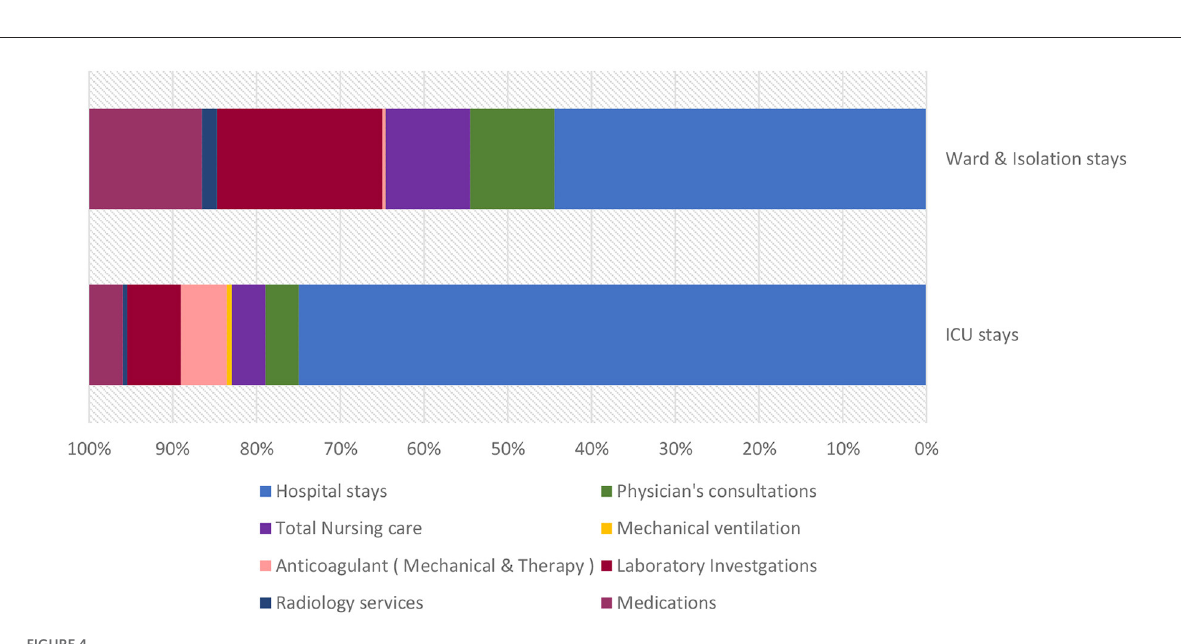
FIGURE4 Distribution of total hospital costs according to locations for hospitalized patients diagnosed with